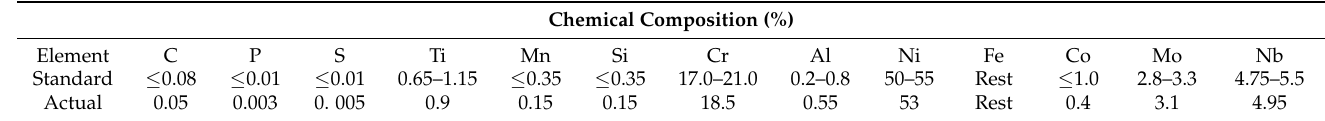
Figure 1. Schematic of ( a ) wiper insert with an additional straight edge adjacent to nose for increased contact length, and ( b ) central inserts with steps on the cutting edges. The chemical composition of Inconel 718 was in line with the standard, see Table 1. Table 1. Chemical Composition of Inconel 718 (standard vs. actual).